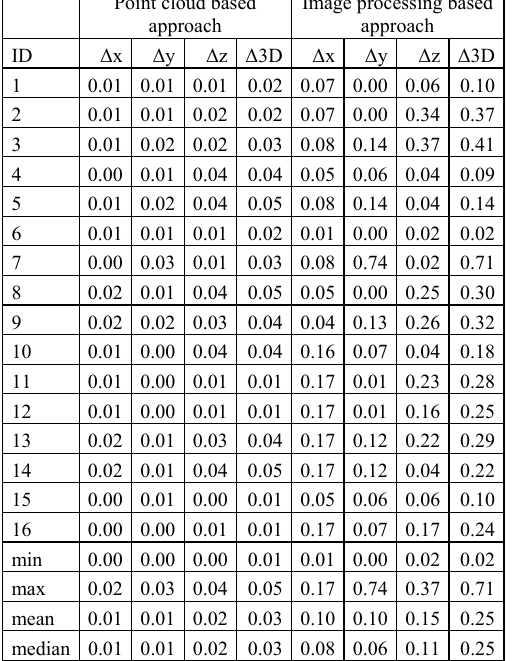
Figure 4. Orthogonal distance in [cm] between reconstructed node and benchmark plane for point cloud based approach (top) and image processing based